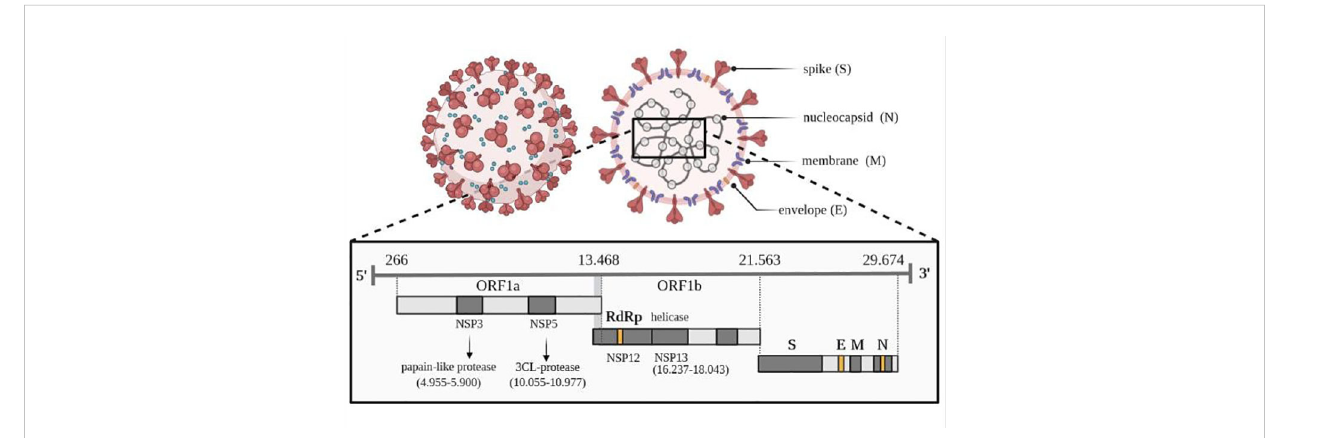
FIGURE 2 Viral genome of SARS-CoV-2. Own drawing, based on (66).